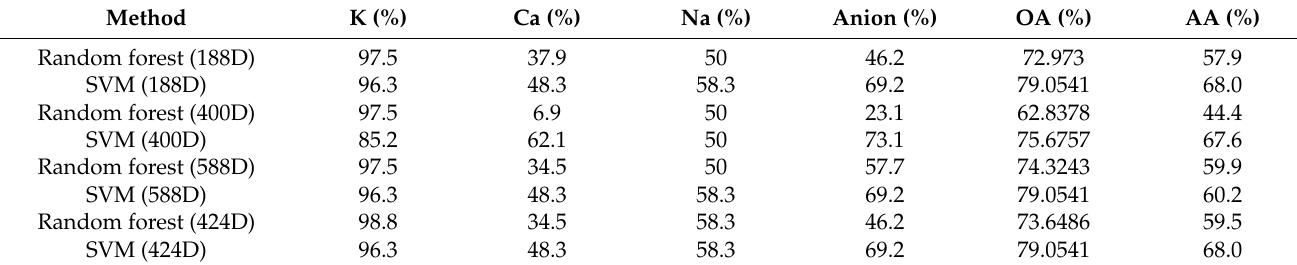
Table 5. Prediction results for the voltage-gated ion channels-four